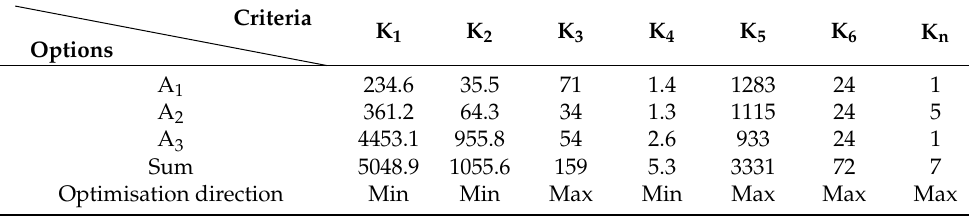
Table 19. The initial Matrix P of alternative solutions.